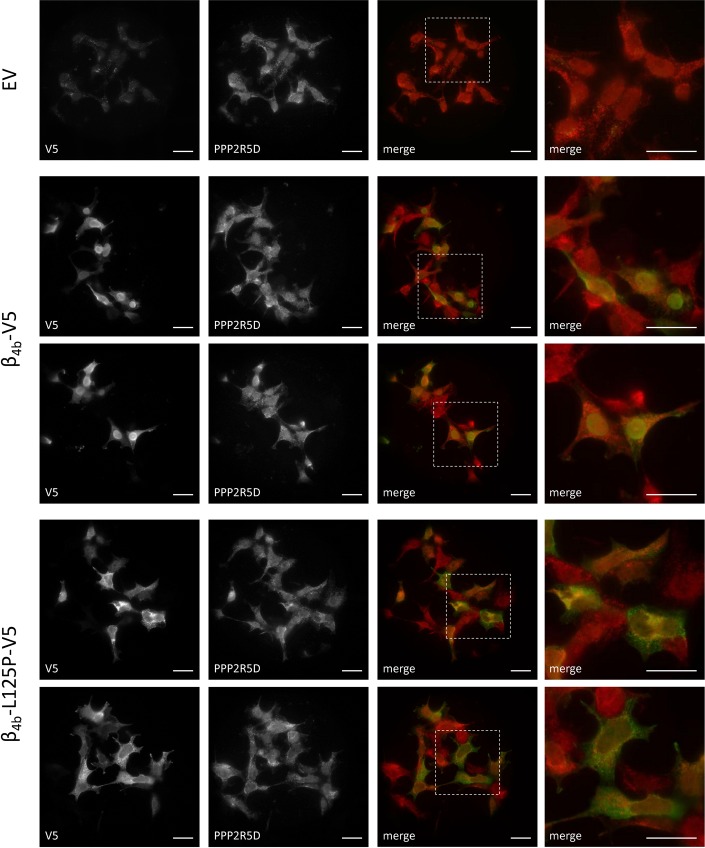
Subcellular localization of PPP2R5D is not affected by expression of β4b wildtype or the L125P mutant in HEK293T cells.HEK293T cells were plated on collagen-coated glass slides and transiently transfected with the indicated constructs. β4b-V5 and β4b-L125P-V5 were stained by mouse anti-V5 antibody (green); endogenous PPP2R5D was visualized using rabbit anti-PPP2R5D antibody (red). Representative images of two independent experiments are shown. White boxes indicate magnified areas of specimen shown on the very right-hand side. Scale bars, 10 μm. EV: empty vector (control).